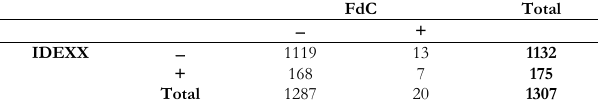
Joint distributions of IDEXX and